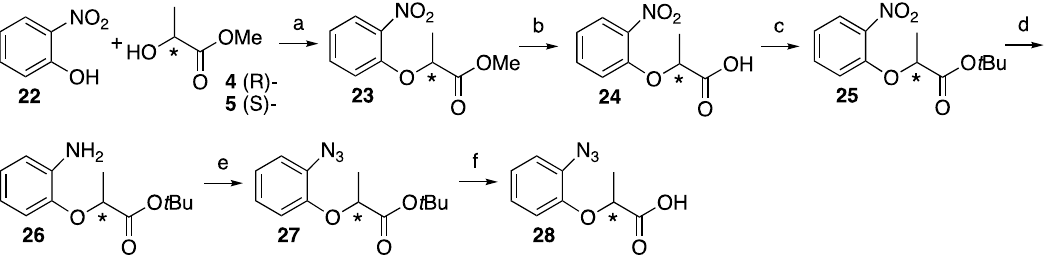
Figure 4. Synthesis of 2-azide-substituted lactisole derivatives. ( a ) (1) PPh 3 , CH 2 Cl 2 , 0 ◦ C, 10 min; (2) DEAD, CH 2 Cl 2 , rt, 8 h, ( S )- 23 quant., ( R )- 23 quant., ( b ) NaOH, CH 3 OH, reflux, 1h, ( S )- 24 quant., ( R )- 24 quant., ( c ) t -Butyl bromide, K 2 CO 3 , tetrabutylammonium bromide, dimethyl acetamide, 55 ◦ C, 2.5 h, ( S )- 25 77%, ( R )- 25 82%, ( d ) H 2 , Pd / C, CH 3 OH, rt, 1 h, ( S )- 26 73%, ( R )- 26 89%, ( e ) NaNO 2 , HCl, H 2 O, 0 ◦ C; (2) NaN 3 , 0 ◦ C, 30 min, then rt, 30 min, ( S )- 27 quant., ( R )- 27 89%, ( f ) 4 M HCl, dioxane, rt,